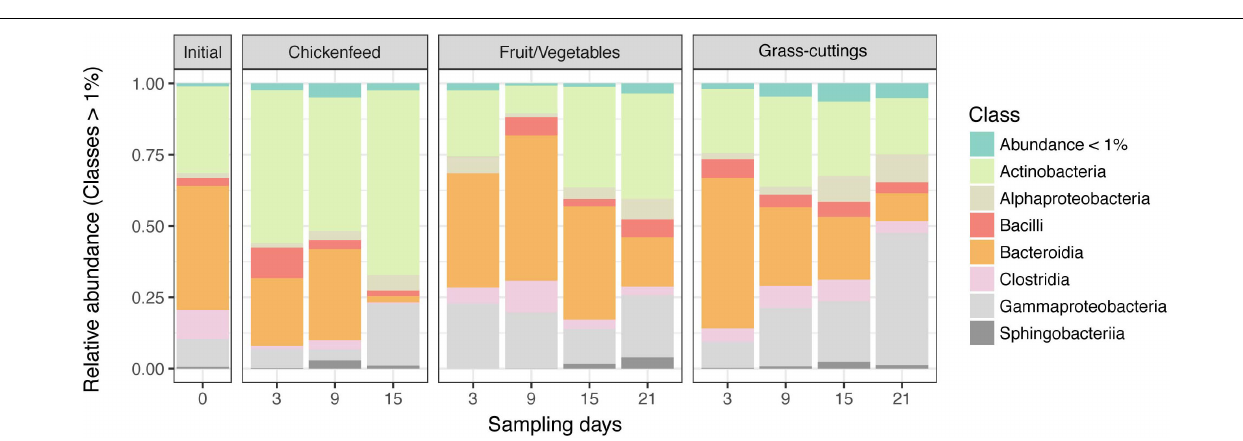
FIGURE 5 | Relative abundance of bacterial classes in gut samples collected during the development of Black Soldier Fly larvae. Operational taxonomic units (OTUs) with a relative abundance lower than 1% were summarized. Note that the significance of differences between sample groups was tested at fine scale delinetation, i.e., the level of Genus and 97% OTUs. The community composition on class level is shown for simplicity instead of a more detailed scale. The microbiome composition of the initial population is derived from 6-day old larvae. All guts were analyzed in triplicates ( n =